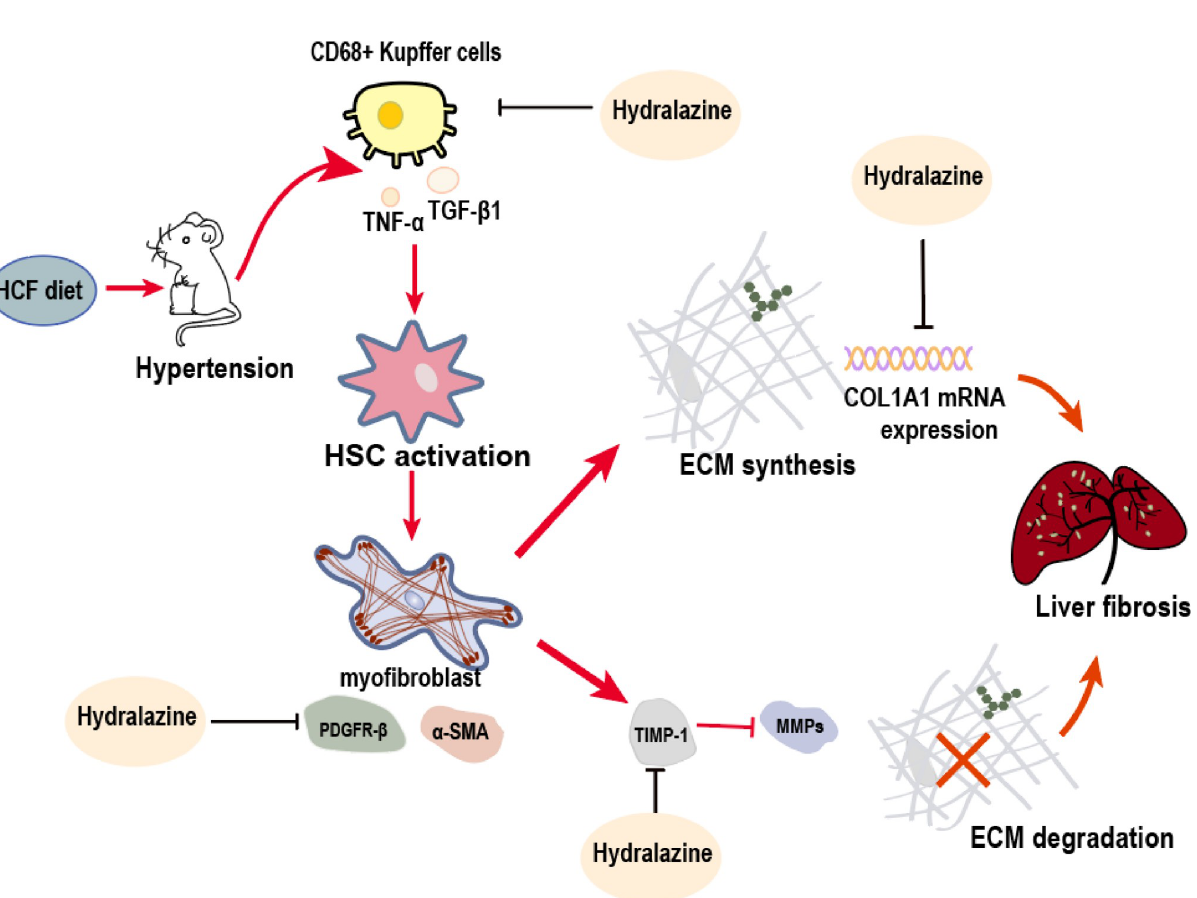
Fig 8. The possible mechanism underlying hepatic fibrogenesis during the progression of hypertension-associated NASH [9,10,14]and inhibition by hydralazine. The combined action of hypertension and HFC diet induces increased aggregation of CD68-positive Kupffer cells and results in the elevation of both serum TGF- β 1 and TNF- α , the cytokines involved in liver inflammation and fibrosis. These cytokines, derived from Kupffer cells or other types of liver cells, induce increased activation of HSCs, which then differentiate into fibrogenic myofibroblasts and produce the major components of ECM (such as collagen), indicated by elevated upregulation of α -SMA and PDGFR- β . Meanwhile, myofibroblasts also participate in TIMP1 expression, the inhibitor of MMPs. HFC diet induced greater increase in serum TIMP1 as well as a greater decrease in MMP activities in hypertensive context compared with the ones under normotensive conditions. Since increased collagen synthesis was not noted in the hypertensive context, hypertension mainly enhanced the effects of HFC diet on ECM degradation and further resulted in more severe liver fibrosis. On the other hand, hydralazine, the antihypertensive agent, significantly attenuates the progression of HFC-induced liver fibrosis under hypertensive conditions by suppressing the aggregation of Kupffer cells and the elevation of serum TNF- α . It also reduces HFC-induced increases in the hepatic expression of PDGFR- β protein and COL1A1 mRNA, suggesting that hydralazine suppresses HFC-induced ECM synthesis. Furthermore, hydralazine significantly suppresses HFC-induced elevation of serum TIMP1, whereas its effects on the levels of MMPs are not prominent. Therefore, the effect of hydralazine on ECM degradation is still unclear. In conclusion, hypertension enhances HFC-induced hepatic fibrogenesis through increasing the suppression of MMP- mediated ECM degradation, whereas hydralazine attenuates liver fibrosis development mainly by suppressing HFC-induced ECM synthesis under hypertensive